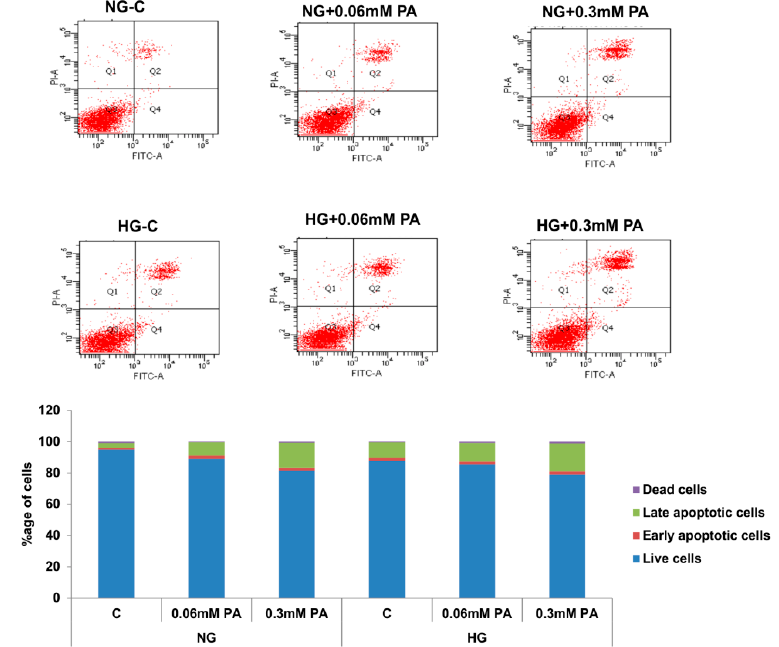
Figure 4. Effect of high glucose/high palmitic acid (HG/HPA) on apoptosis . Apoptosis was measured by FACS analysis, as described previously [25–29]. Histogram shows percentage of viable, early apoptotic, late apoptotic, and dead cells. Representative dot plots from three experiments are shown. The results are mean +/ − SEM of three independent experiments.